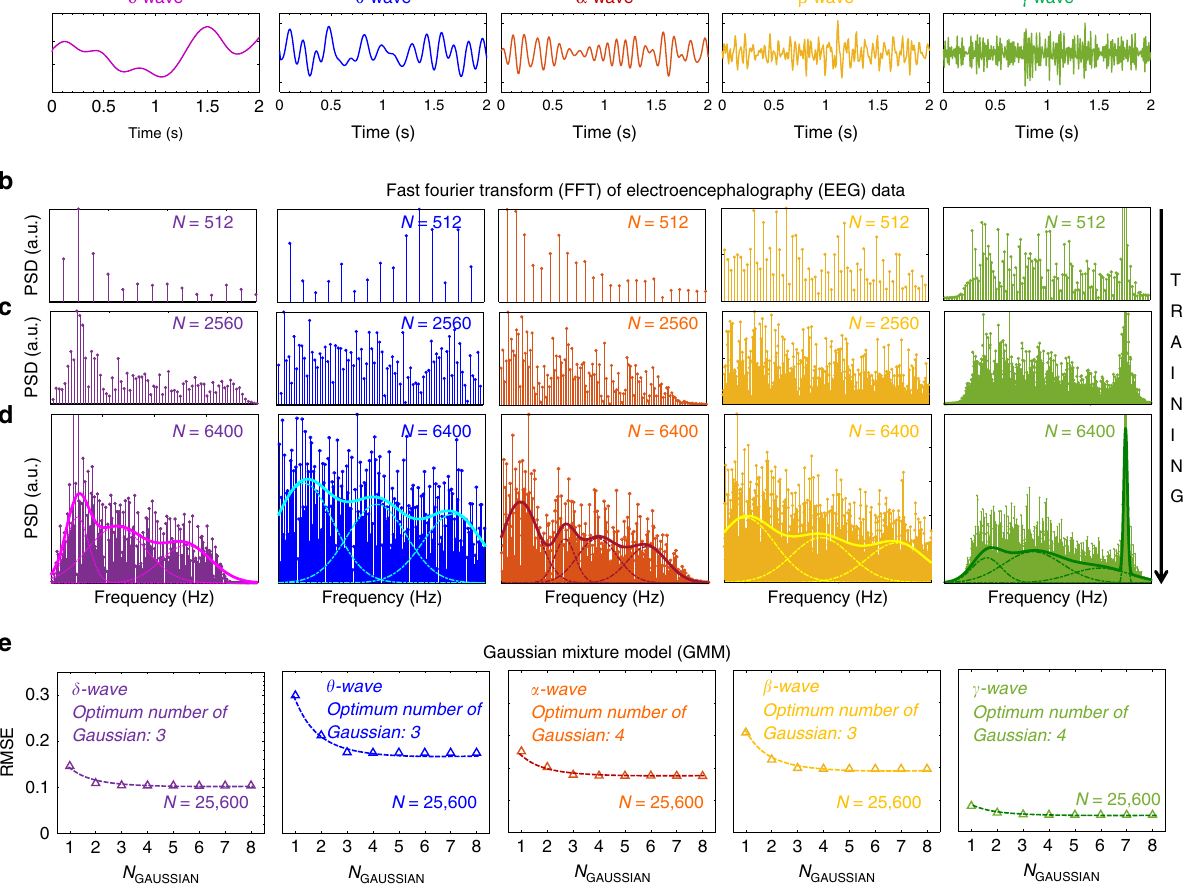
Fig. 4 Recognition of Brainwaves using Gaussian Mixture Model (GMM). a Brainwaves are divided into fi ve frequency bands. 0.5 – 3.5 Hz: Delta waves ( δ ), 4 – 8 Hz: Theta waves ( θ ), 8 – 14 Hz: Alpha waves ( α ), 16 – 32 Hz: Beta waves ( β ) and 32 – 64 Hz: Gamma waves ( γ ). Normalized power spectral density (PSD) as a function of frequency for each type of brainwaves, extracted using the Fast Fourier Transform (FFT) of the time domain Electroencephalography (EEG) data (sequential montage) with increasing sampling times that correspond to sample sizes of ( b ) N = 512, ( c ) N = 2560, and ( d ) N = 6400. As the training set becomes more and more exhaustive, the discrete frequency responses evolve into continuous spectrums. The highly nonlinear functional dependence of the PSDs on frequency for each type of brainwave can be classi fi ed using GMM, which is represented as the weighted sum of a fi nite number of scaled (different variance) and shifted (different mean) normal distributions. e Root mean square error (RMSE) as a function of K, i.e., the number of Gaussian used in the GMMs for each type of brainwave. Clearly, a very limited number of Gaussian synapses are necessary to capture the non-linear